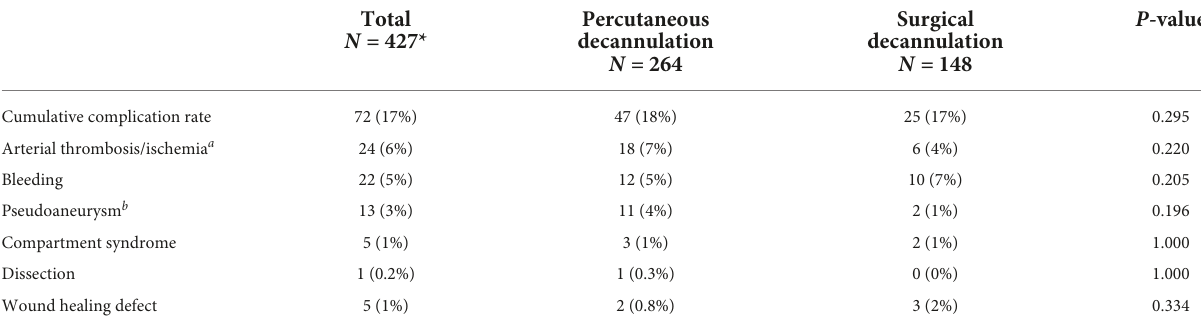
TABLE 6 Complications associated with decannulation in survivors of venoarterial extracorporeal membrane